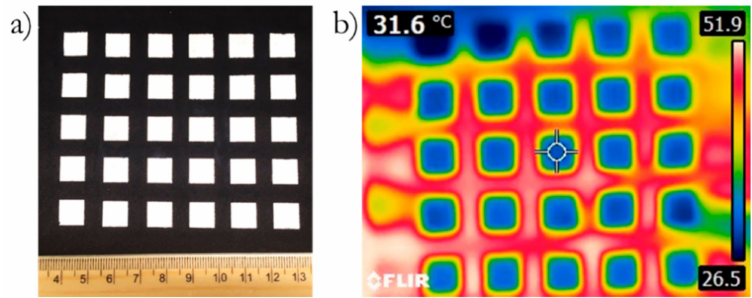
Figure 8. ( a ) An image showing EC-PCM40-BN10 formulation template casted on nylon; ( b ) thermal image of the sample showing temperatures close to 50 ◦ C in the fabric alone while sections containing EC-PCM40-BN10 remain at 31 ◦ C or